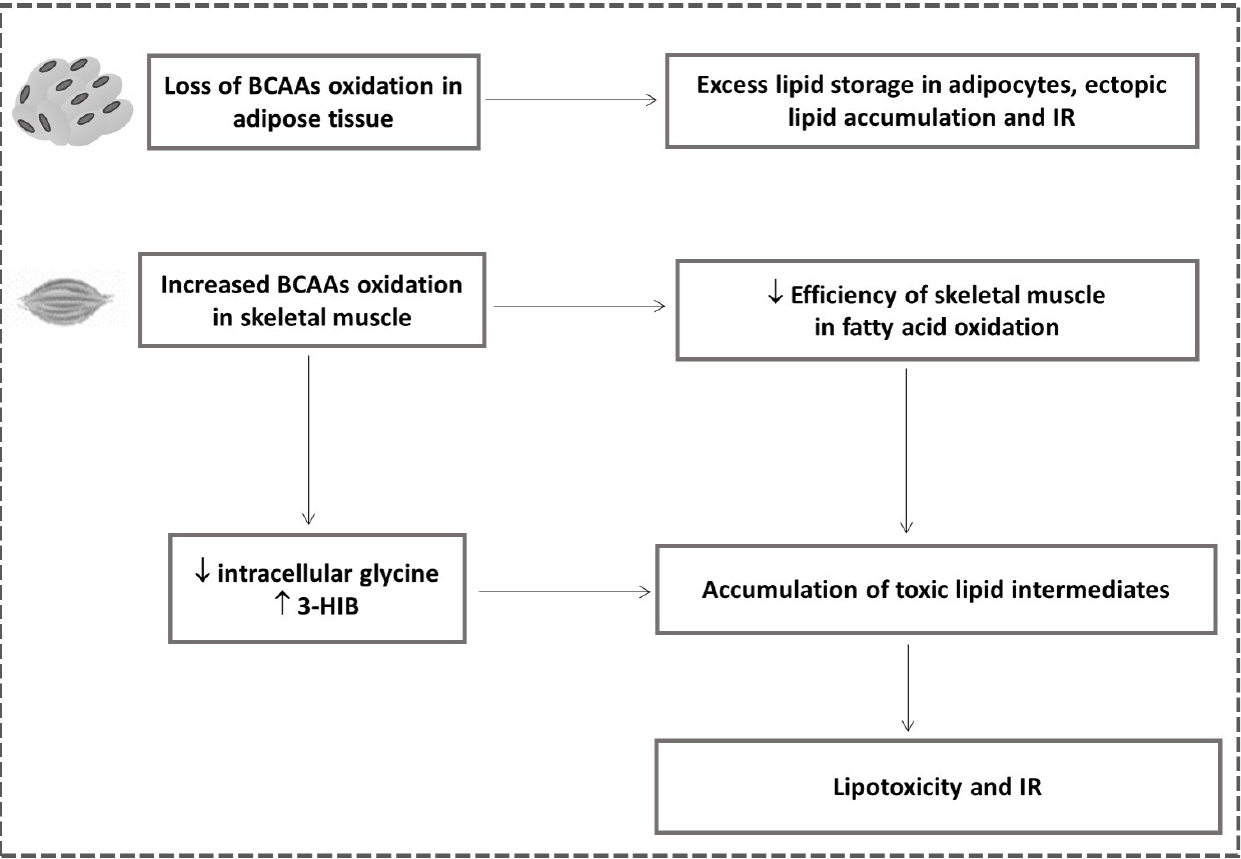
Figure 6. Association between the altered BCAA catabolism in adipose tissue and skeletal muscle with IR ( ↓ downregulated; ↑ upregulated ). with IR ( ↓ downregulated; ↑ upregulated